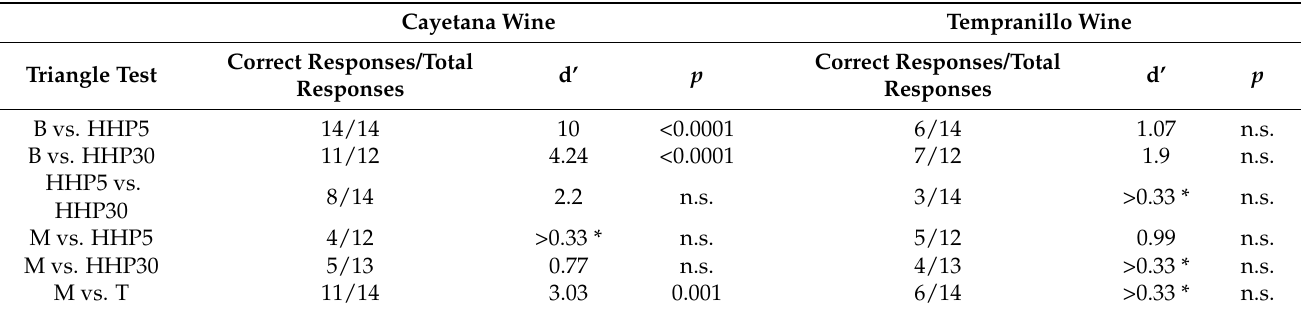
Table 5. Results of the triangular